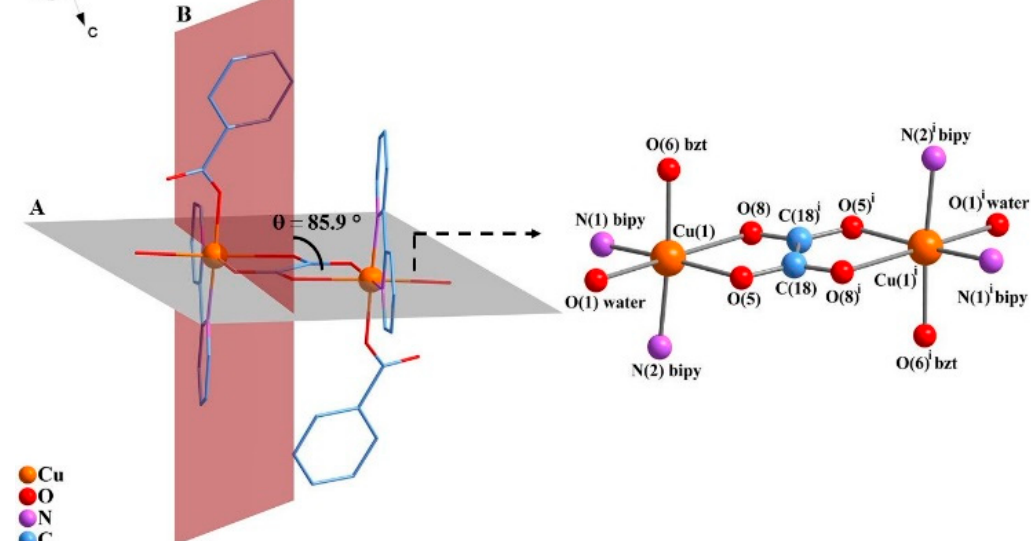
Figure 6. Representation of the dihedral angle ( θ ) between plane A, which contains the ox 2 − bridge, and plane B, which contains the d x 2 − y 2 orbitals. Hydrogen atoms were omitted for clarity. Symmetry code (i): 1 − x, 1 − y, 1 − z. Table 3. Selected magnetostructural parameters for oxalate-bridged copper(II) complexes.